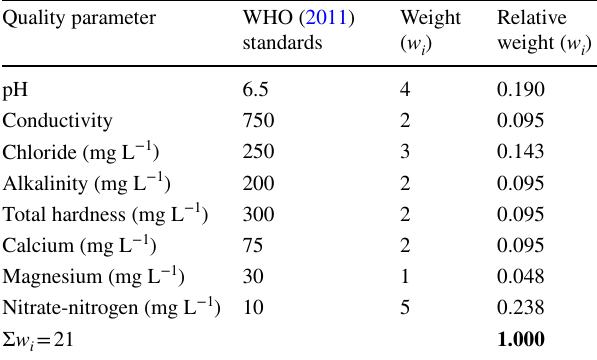
Table 3 Related weight ( W i ) of physical and chemical parameters Quality